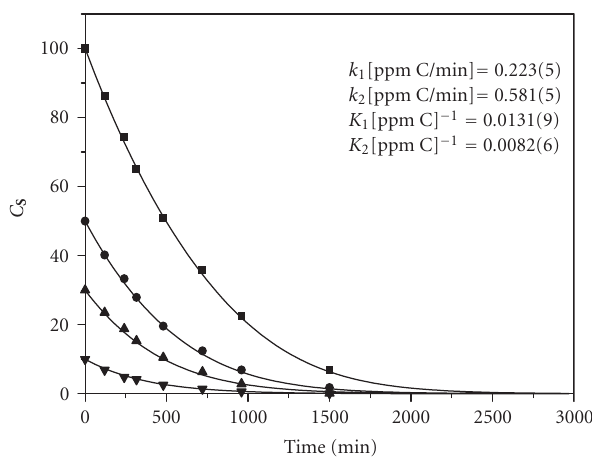
Figure 2: Kinetics of disappearance of total organic carbon (TOC) from gaseous methane in the laboratory-scale photoreactor (see Ex- perimental), expressed as concentrations, C TOC in mg/L of carbon, which was not mineralized, as a function of time, expressed in min- utes, as time necessary to treat 1 L of gas phase. Absorbed radiation power per unit membrane length was 0.30W · cm − 1 during these runs. Photocatalytic membranes used in these experiments did not contain any photopromoting